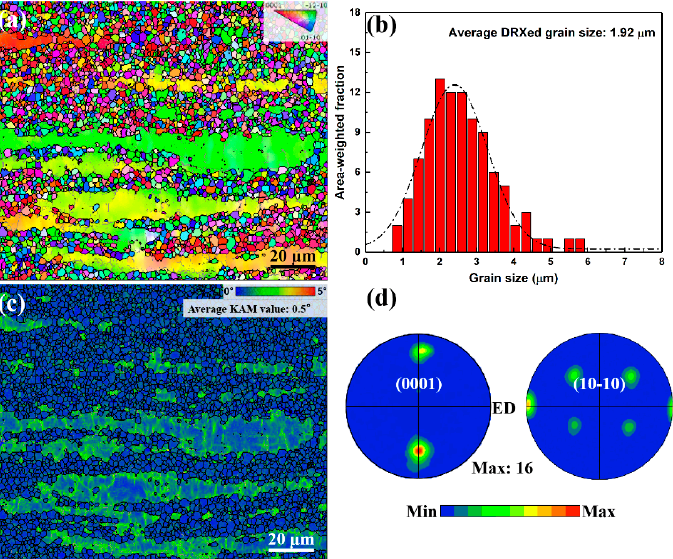
Figure 5. EBSD analyses of the as-extruded alloy: ( a ) IPF map; ( b ) grain size distribution map; ( c ) KAM map; ( d ) (0001) and (10-10) pole figures.